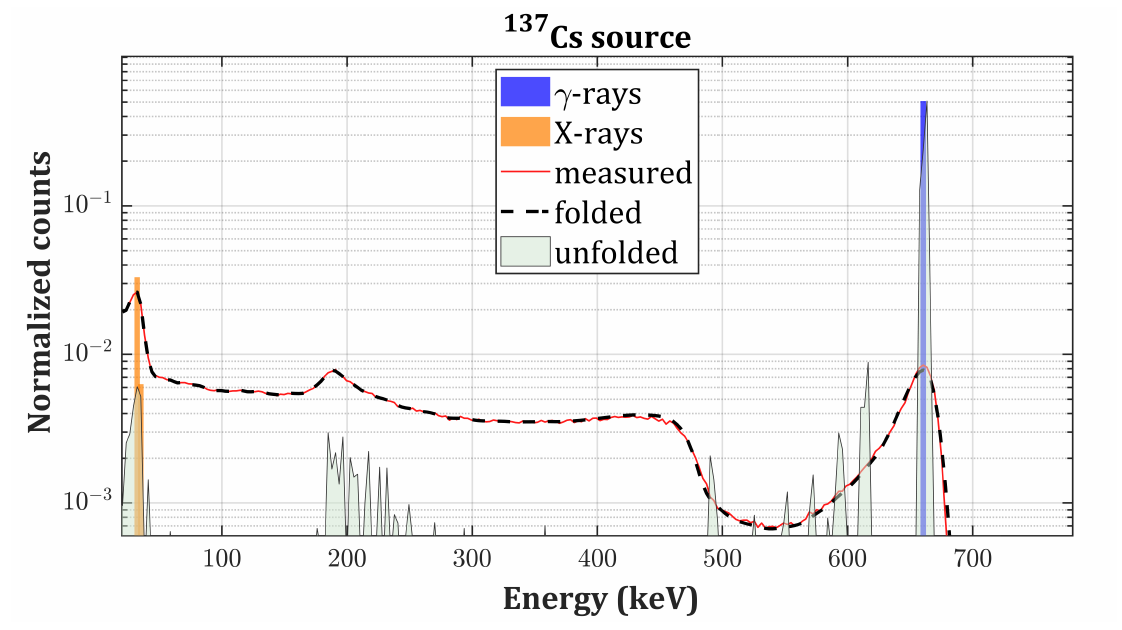
Figure 5. 137 Cs unfolded spectrum (gray curve) compared to the measured spectrum (red curve), the folded spectrum (black dashed curve), and the tabulated intensities of the γ -emissions (blue bars) and X -emissions (orange bars) of 137 Cs on a logarithmic scale.